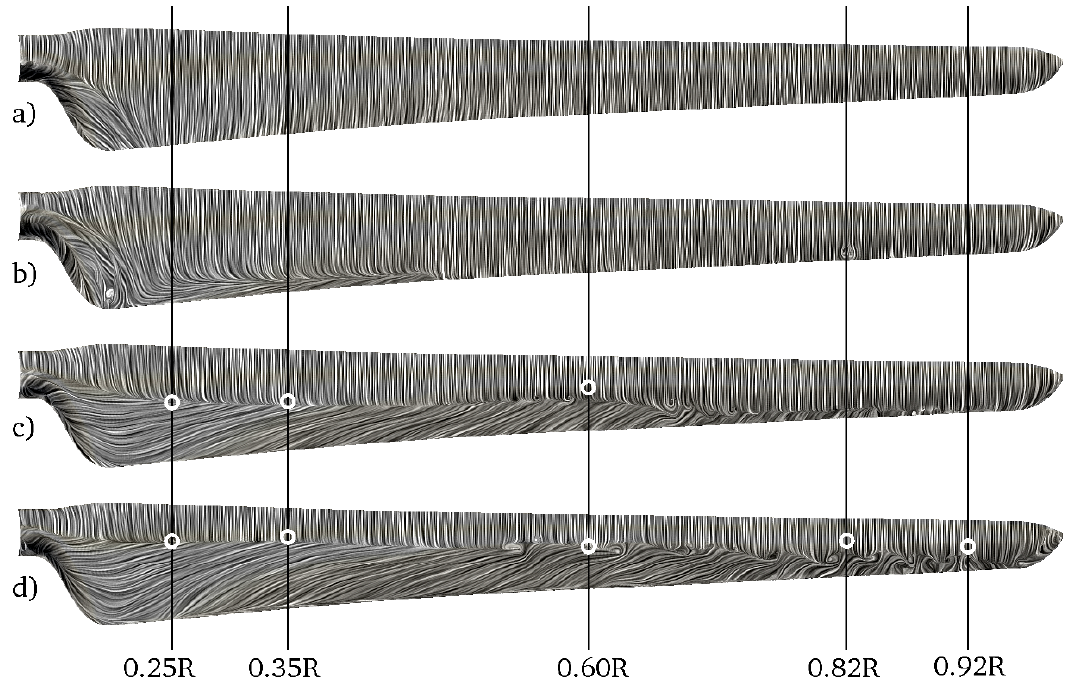
Figure 10. Oil-flow representation of the computed wall shear stress on the suction side at different wind speeds: ( a ) U 1 = 10 m/s, ( b ) U 1 = 15 m/s, ( c ) U 1 = 19 m/s and ( d ) U 1 = 24 m/s. The white dots indicate the point of separation extracted from the experimental C p